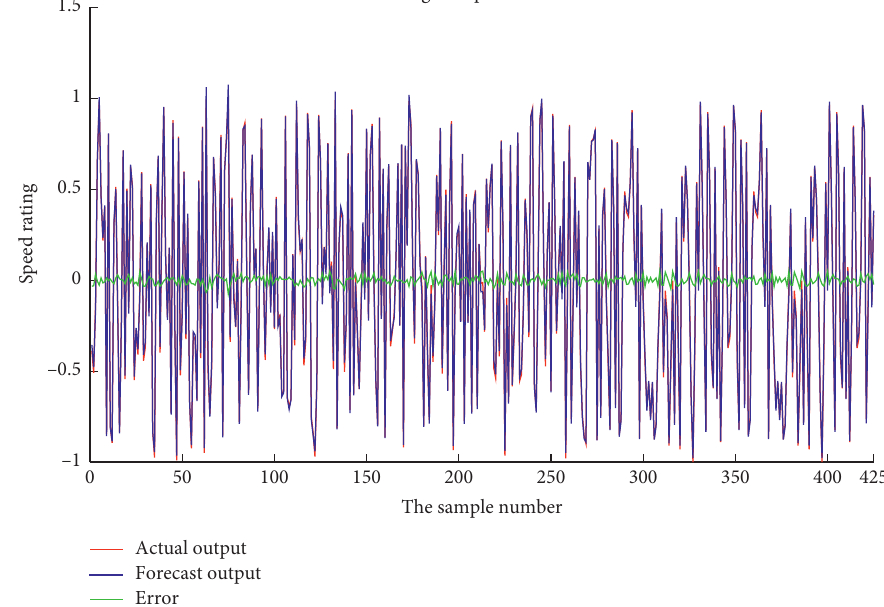
Figure 6: Improved T-S fuzzy neural-network training data prediction